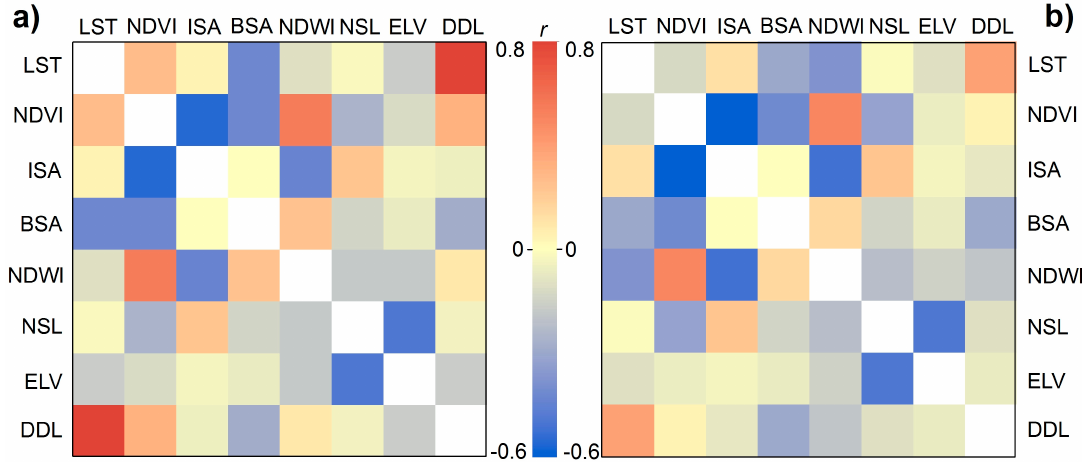
Figure 4. Pairwise Pearson’s linear correlation coefficient r among the eight predictors ( a ) before and ( b ) after deseasonalization of the LST, NDVI, NDWI, and DDL time series.